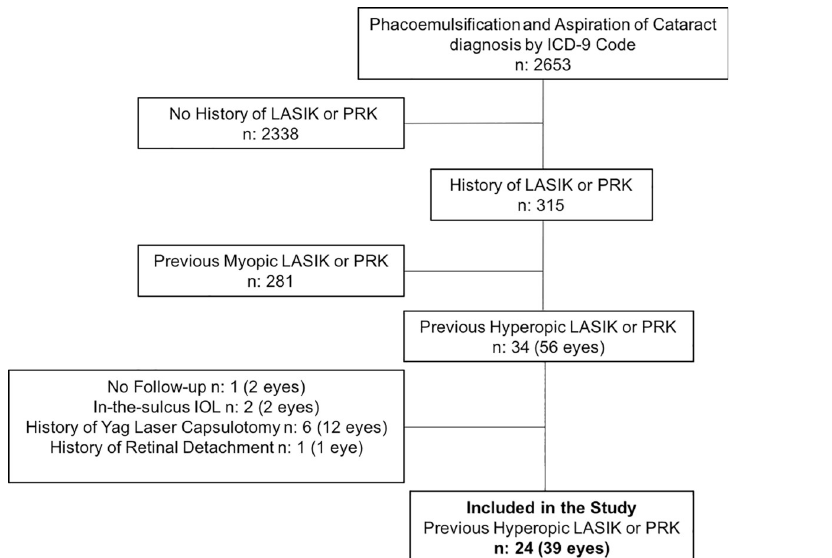
Fig 1. Study design and inclusion of patients during clinical chart review.